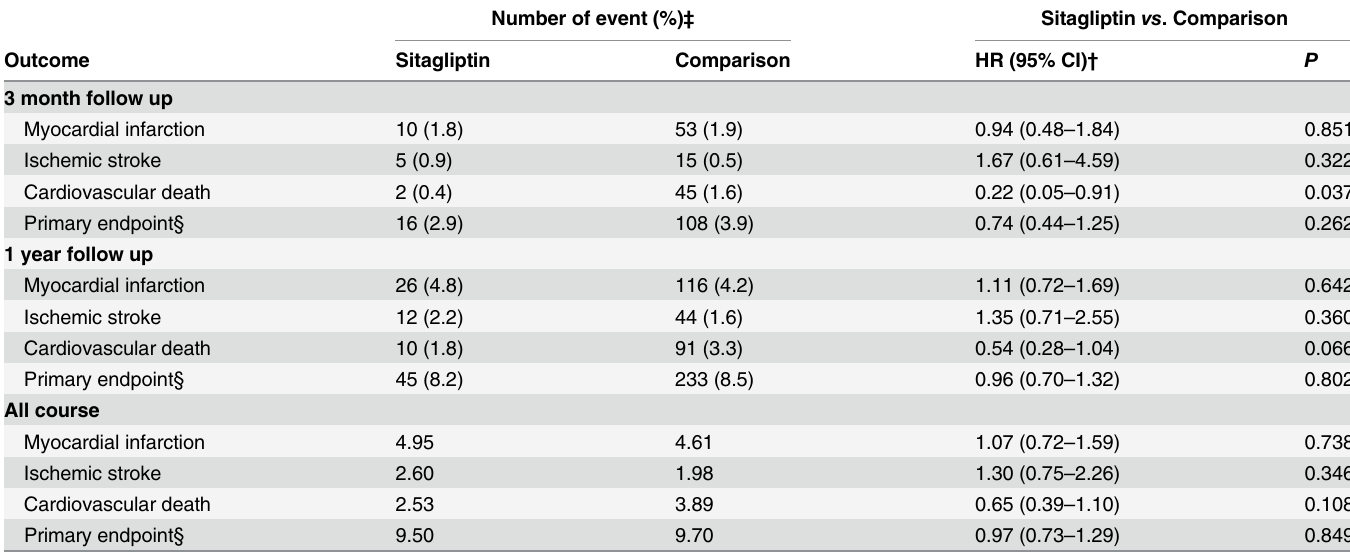
Table 3. Primary outcomes in various follow up